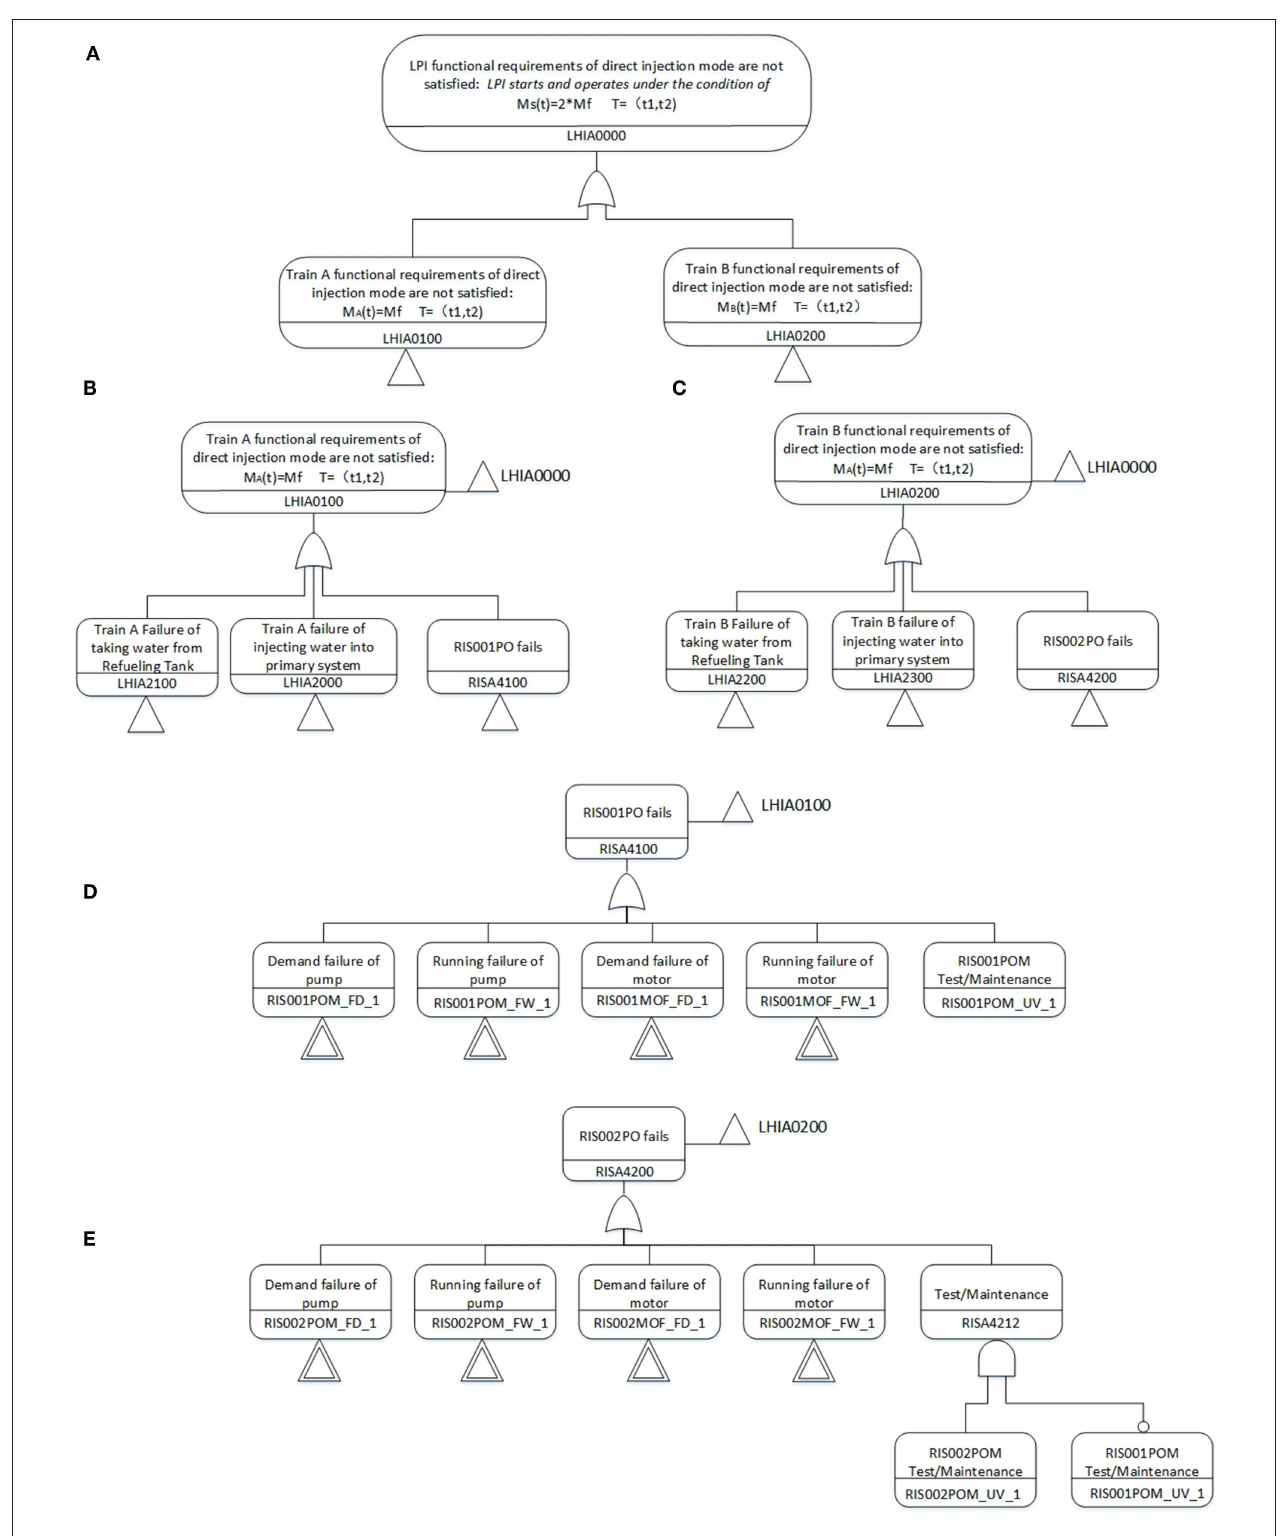
FIGURE 7 | Mission-based FT of